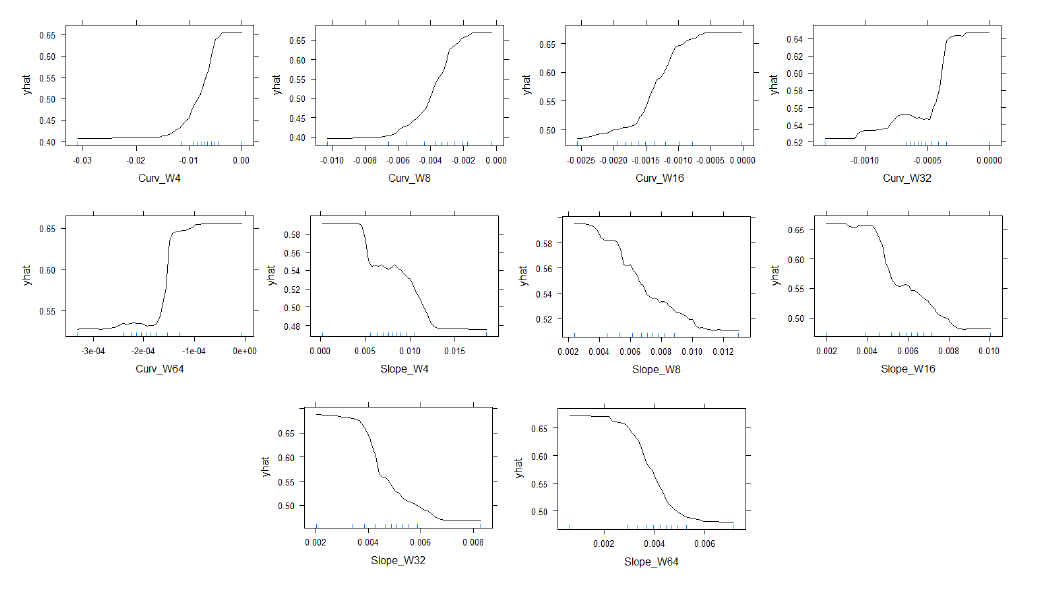
Figure 11. Partial dependence plots obtained for negative Curvature and Slope with NDVI for sliding window-based